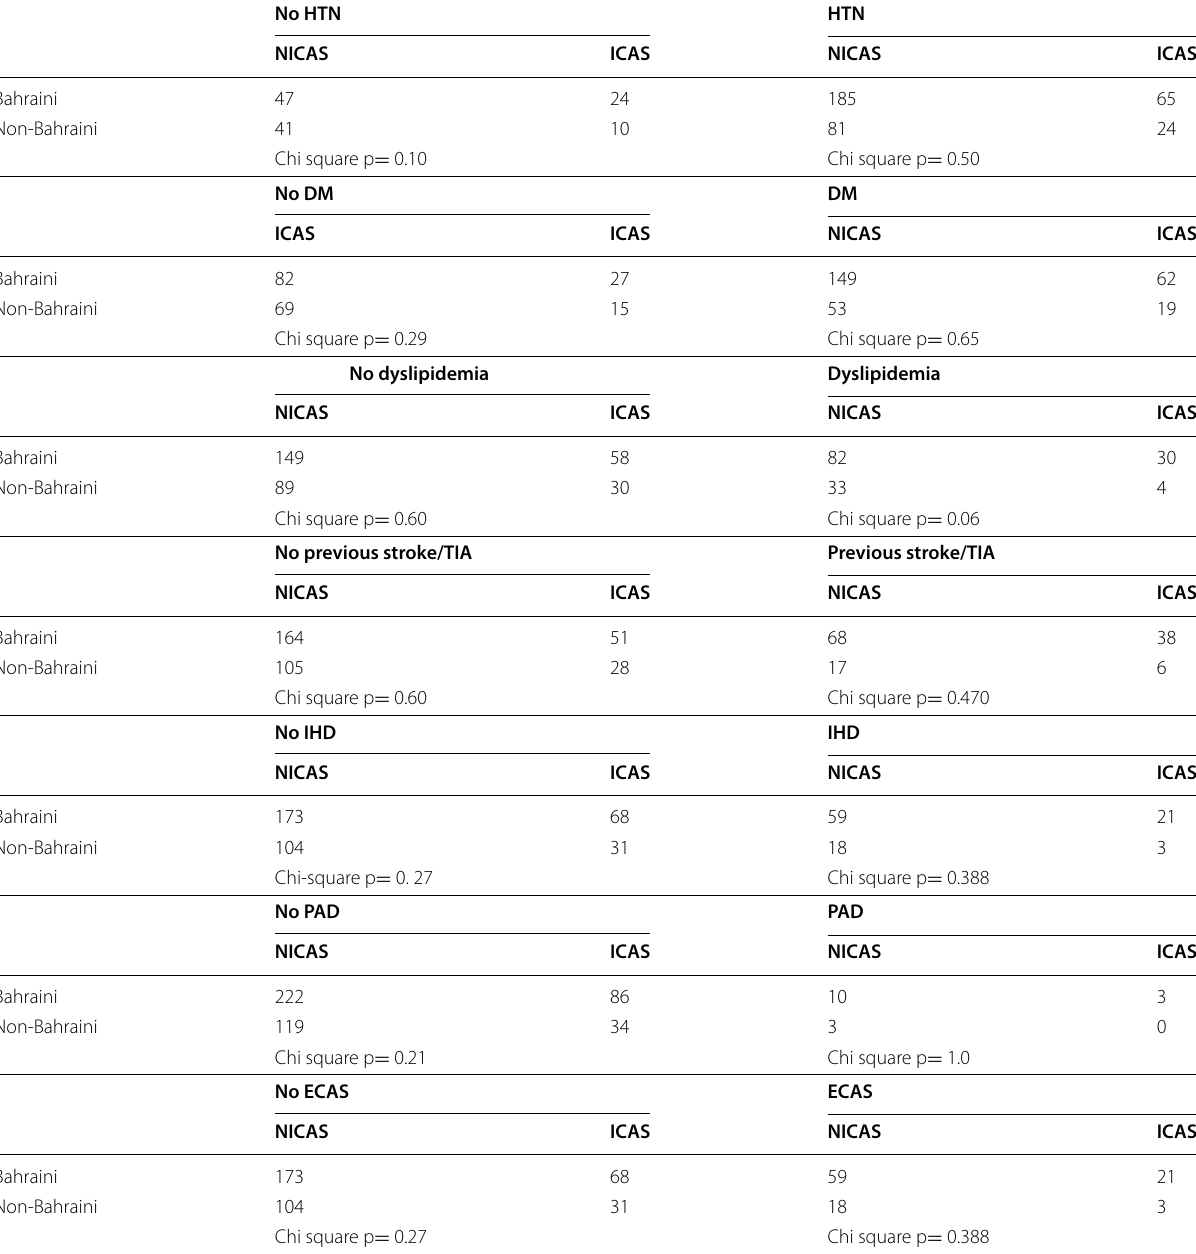
Table 3 Distribution of risk factors across